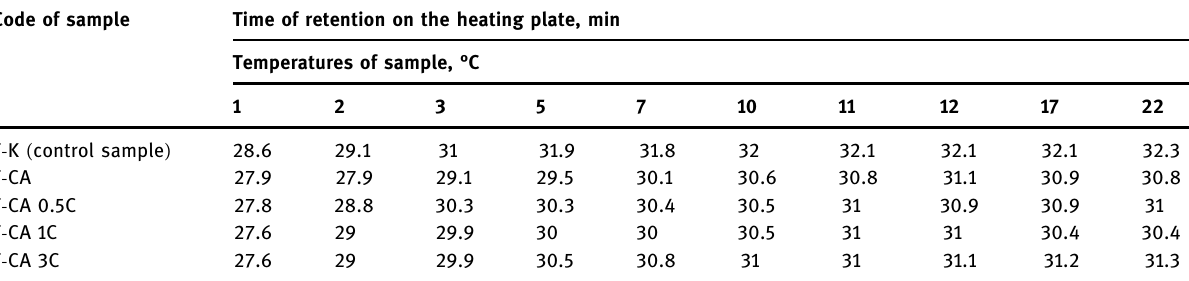
Table 9: Temperatures of textile samples coated with pure CA and composites of CA with MWCNT during heating Code of